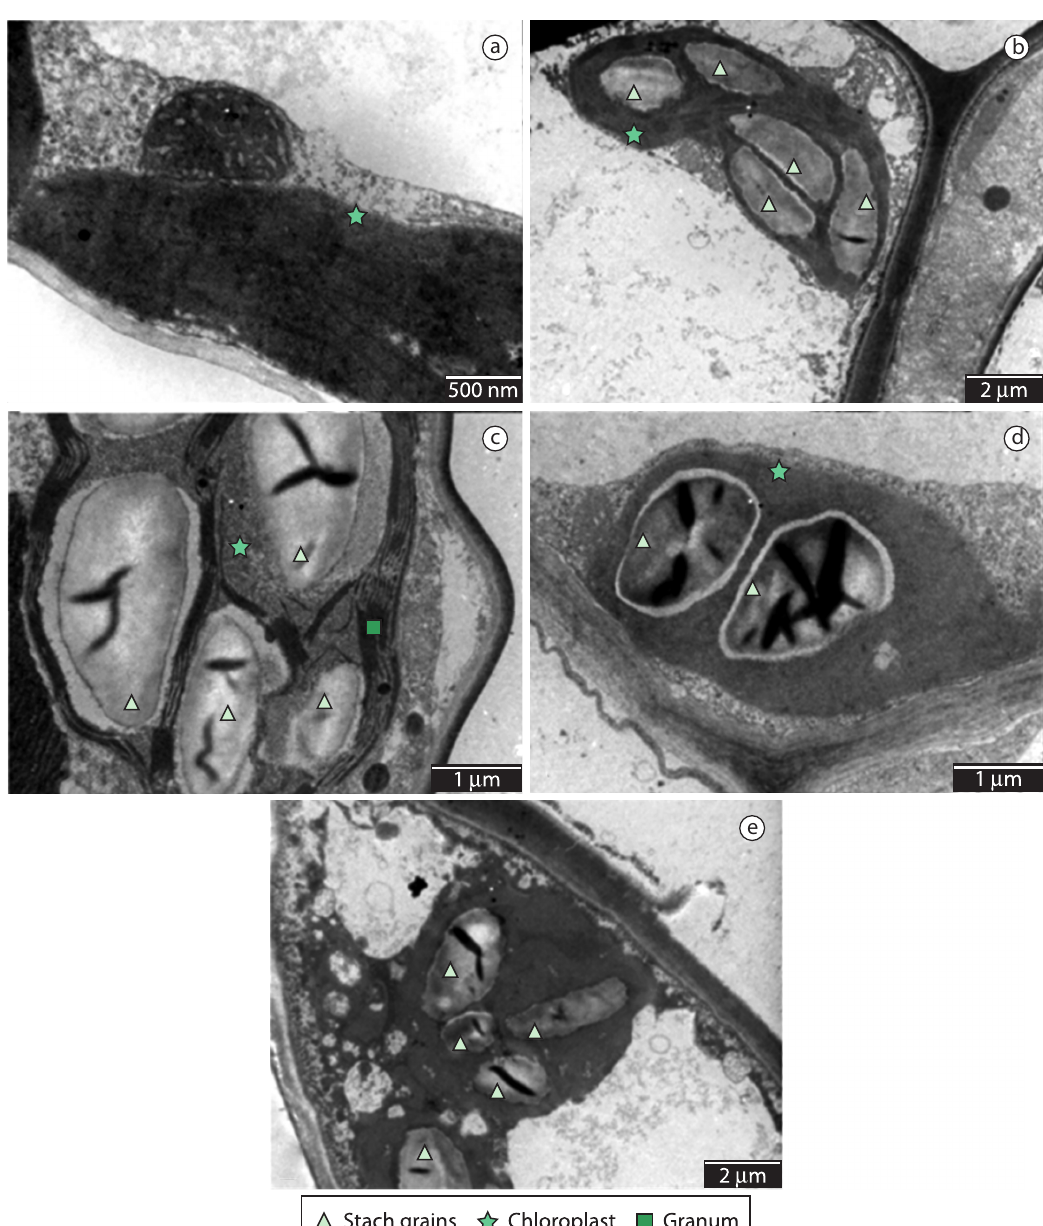
Figure 1. Transmission electron microscopy of the leaf of Salvinia auriculata showing stach grains, chloroplast, gra- num. a) Plant control, b) plant subjected to 100 mM NaCl, c) plant subjected to 200 mM NaCl, d) plant subjected to 100 mM Na SO , e) plant subjected to 200 mM Na 2 4